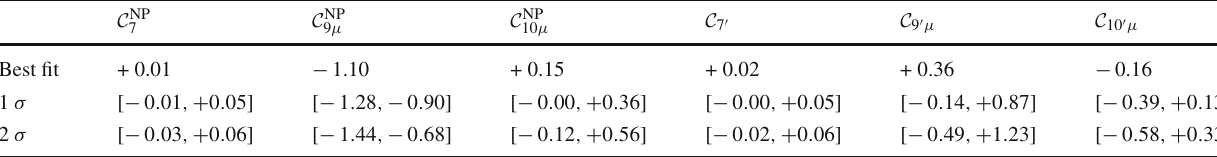
Fig. 1 From left to right: allowed regions in the ( C NP available data (fit “All”) upper row or LFUV fit lower